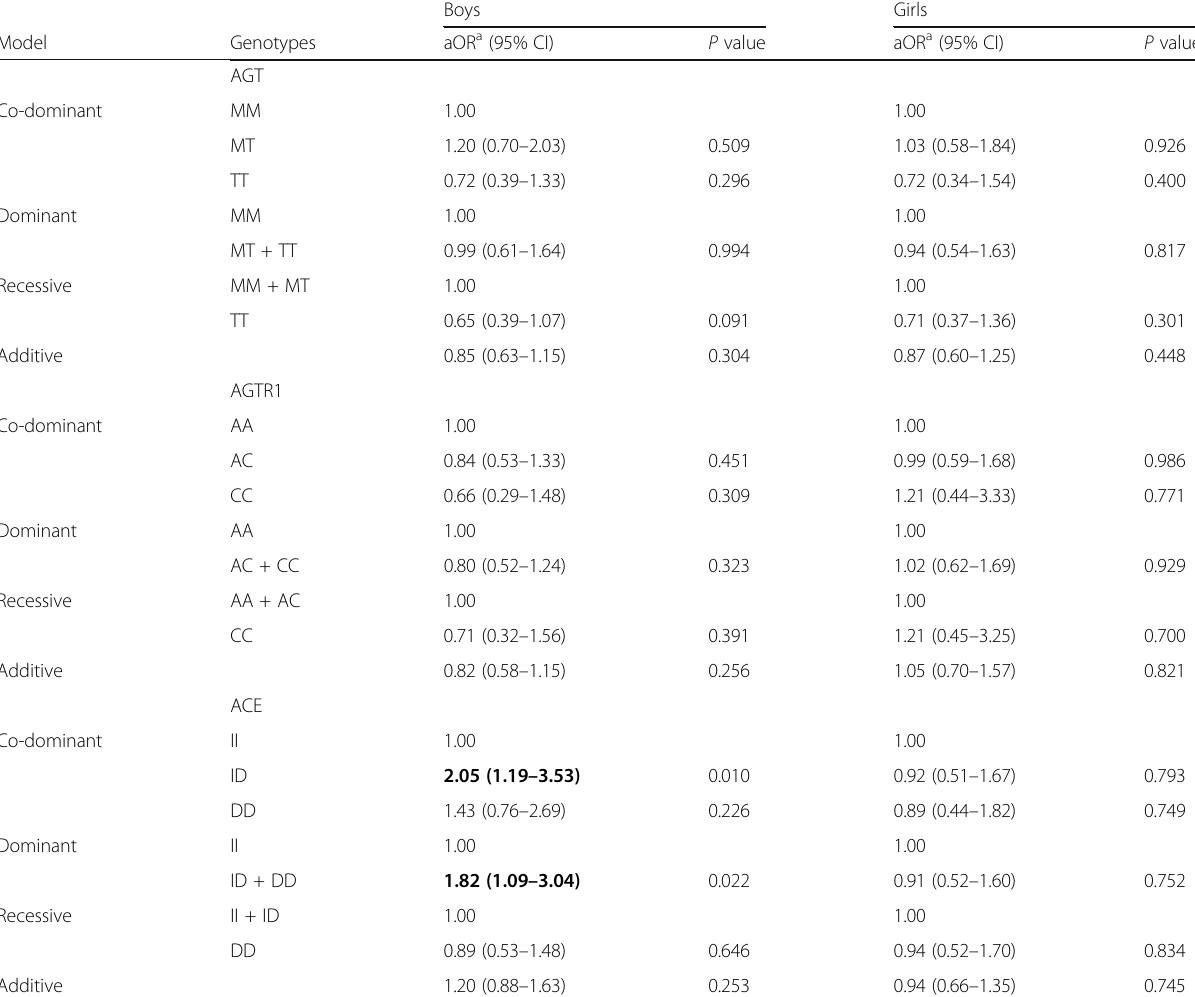
Table 4 Associations of AGT, AGTR1, and ACE polymorphisms with high blood pressure by sex (multivariate analysis) Boys